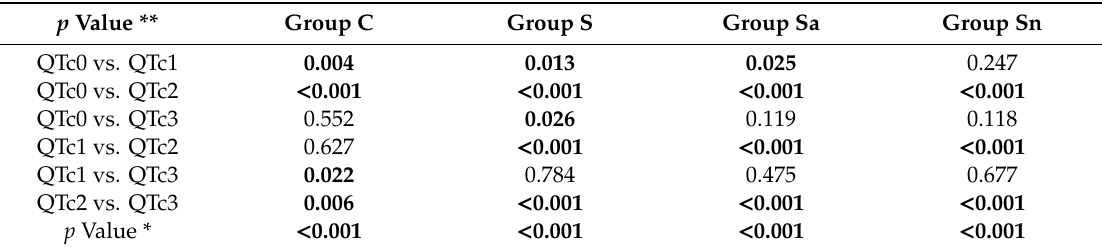
Table 4. Inter-time comparison of QTc intervals in ECGs on admission to hospital and during three phases of